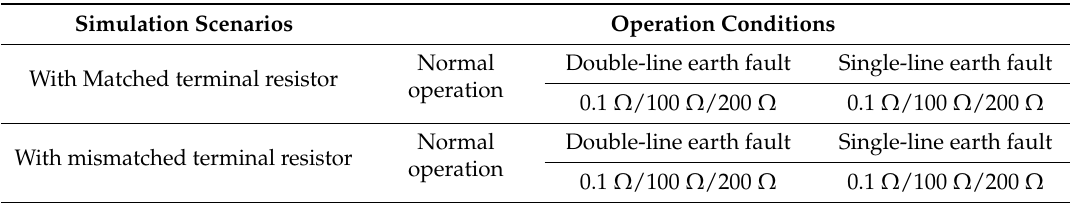
Table 3. Simulation scenarios in case